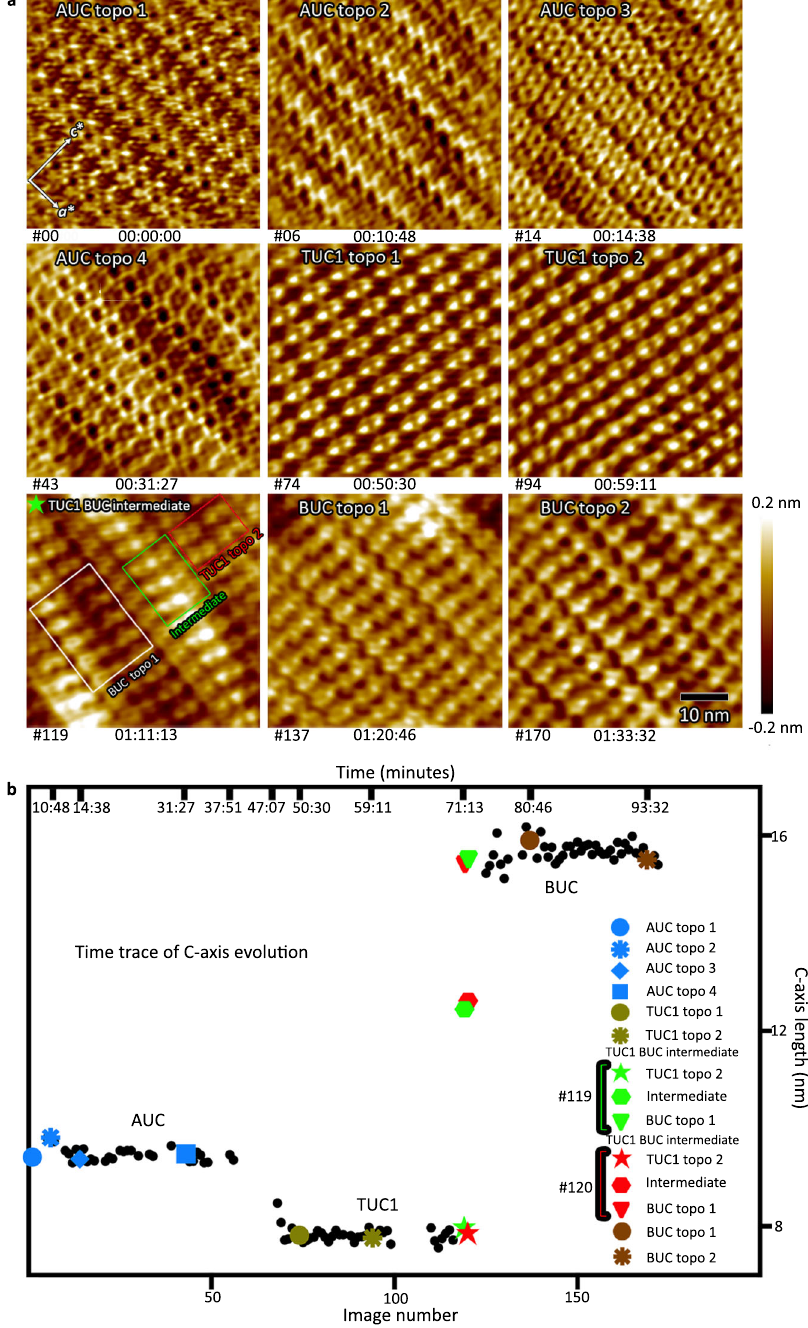
Fig. 2 Ligand-triggered crystal lattice transition observed by AFM. a The time-lapsed representative snapshots of the ligand-induced phase transitions in ac face of the riboA crystal. AUC apo unit cell, TUC1 transition unit cell 1, TUC2 transition unit cell 2, BUC bound unit cell. The order of morphological changes and phase transitions is as follows: AUC topography (topo) 1, AUC topo 2, AUC topo 3, AUC topo 4, TUC1 topo 1, TUC1 topo 2, TUC1 – BUC intermediate, BUC topo 1, and BUC topo 2. b The plot of c -axis length in nanometers vs. serial image number and time (top axis) during the lattice transition. This plot summarizes the ligand-triggered polymorphic transition. Gaps in the plot are the periods when the changes in the crystal phase resulted in the loss of contact with the crystal surface during AFM imaging. Source data are provided as a Source Data fi s-mixed (AUC-10 s), and AUC 25 s-mixed (AUC-25 s) data sets changes likely re fl ect the conversion of apo1 (ligand incompetent) (Fig. 4 and Supplementary Table 5). For both molecules in the toward apo2 (ligand competent), which involves large motions in asymmetric unit (apo1 and apo2), large changes relative to the the hinge and P1, including an ~180° rotation of A23 out of the starting apo conformations are observed at 10 s (Fig. 4a, b, left binding pocket. Between 10 and 25 s, fewer changes are observed panels). Changes in apo1 are primarily localized to the top of the 5 ′ in apo1, although prominent peaks appear near latch residues strand of P1, beginning at G18, and extending through the fl exible 47 – 49, as well as G44 (Fig. 4a, right), and could be further indi- hinge region that includes A21, U22, and A23 (Fig. 4a, left). These cative of changes toward the apo2 conformation. At 10 s, the